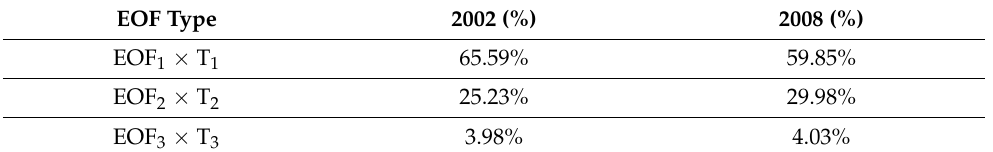
Table 1. Variance contribution of the first three EOF i (i = 1, 2, 3) of the TEC in each of 2002 and 2008.